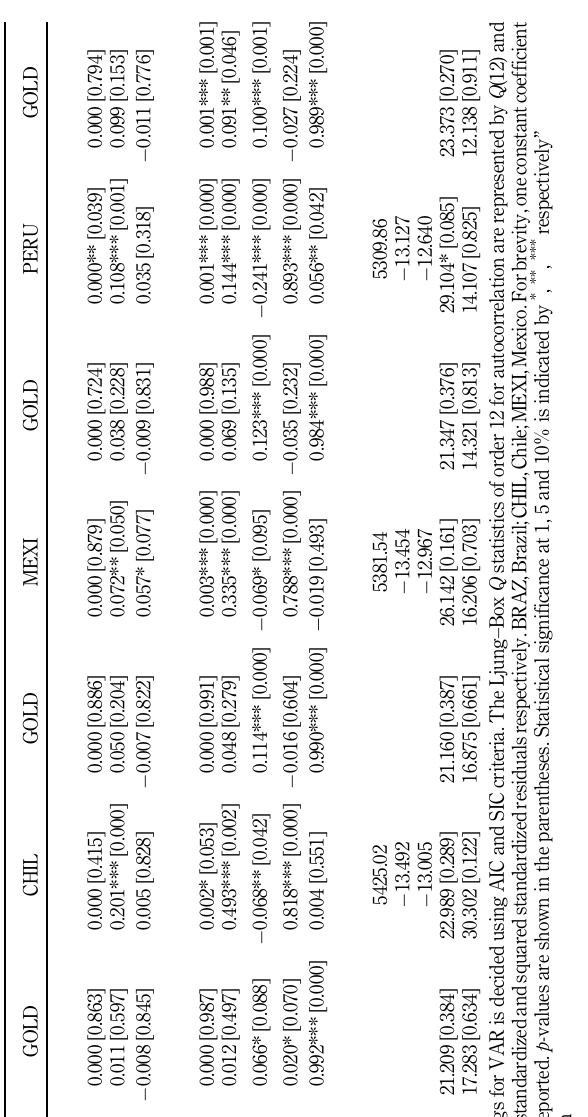
Table 5. Estimates of bivariate VAR-BEKK-GARCH for gold assets and Latin American equity markets during Chinese equity market